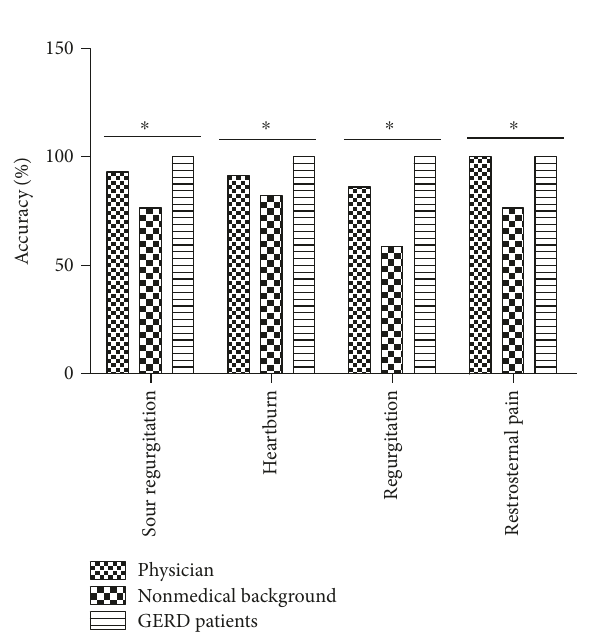
Figure 3: Accuracy of understanding classic re fl ux symptoms in physicians. ∗ P < 0 05 compared with that in the GI department, Fisher ’ s exact